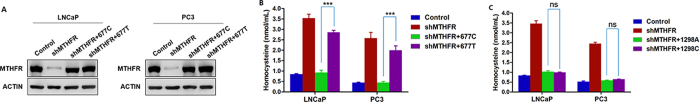
MTHFR c.677T variant leads to a notably increased cellular homocysteine level in PCa cell lines.(A) Knockdown efficiency of shMTHFR and protein expression of MTHFR after restoration of wild-type or mutant MTHFR gene was measured by western blot. The full-length blots were displayed in Supplementary Figure 1. (B) c.677T variant of MTHFR gene leads to an increased cellular homocysteine level in both LNCaP and PC3 cell lines. (C) c.1298C variant of MTHFR gene has no effect on the cellular homocysteine level in LNCaP and PC3 cell lines. ***Indicates P < 0.001, ns indicates no significance.